Question: Provide a publication-style caption for this figure.
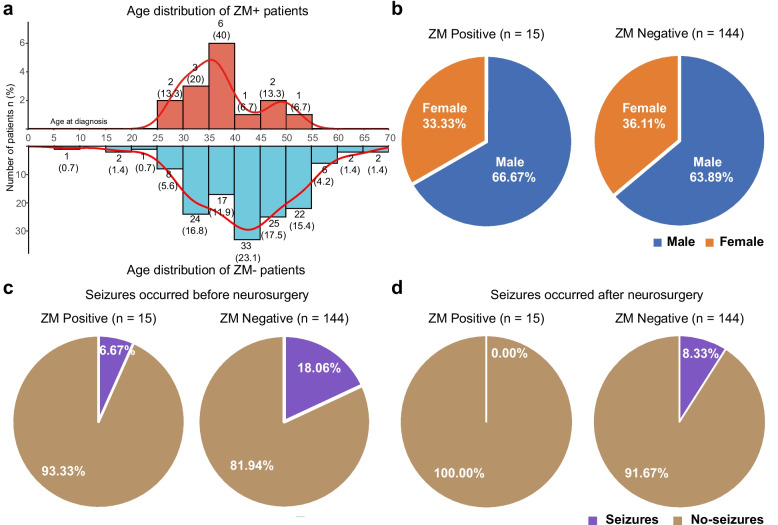
Answer: Clinical characteristics associated with ZM fusion status in sGBM. a Age distribution of ZM-positive and ZM-negative patients. ZM-positive patients were mainly concentrated in younger to middle-adult age groups, whereas ZM-negative patients showed a broader age range. b Sex distribution of ZM-positive and ZM-negative patients. c Preoperative seizure occurrence in ZM-positive and ZM-negative groups. Seizures were less frequently observed in ZM-positive patients before neurosurgery. d Postoperative seizure occurrence in ZM-positive and ZM-negative groups. No postoperative seizures were observed in the ZM-positive cohort, whereas a small proportion of ZM-negative patients experienced postoperative seizures